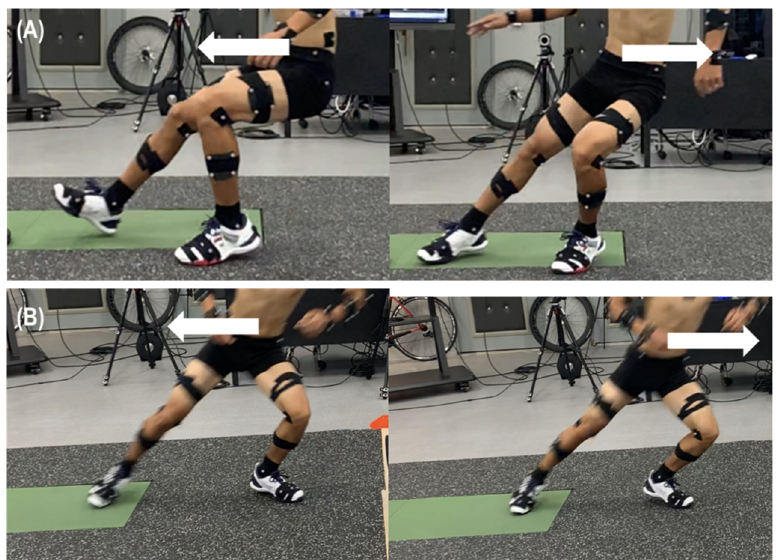
Figure 3. ( A ) Forward braking motion and ( B ) Side braking motion (sidestep). (Arrows indicate the direction of movement).